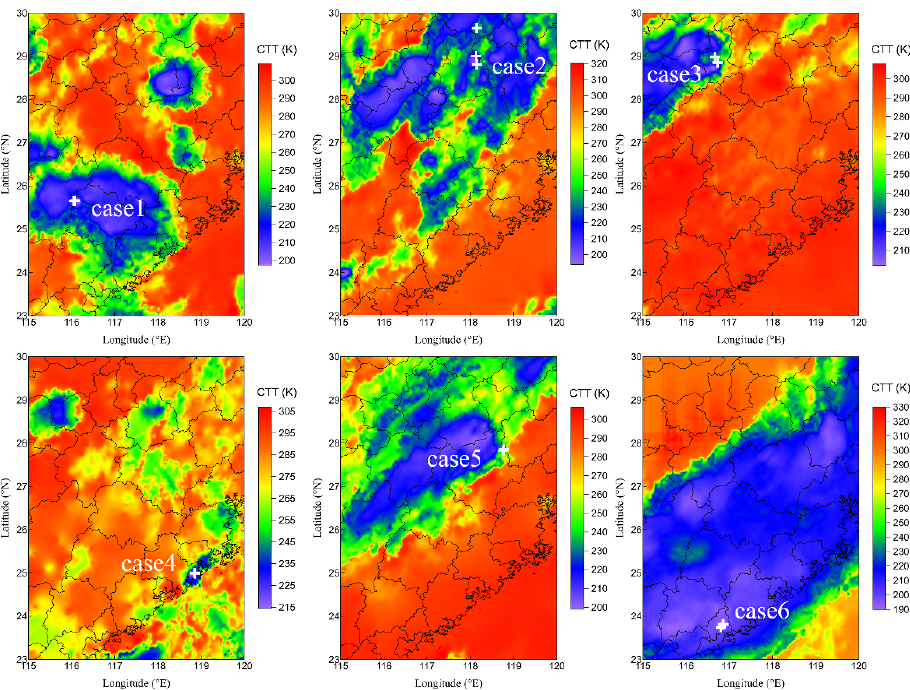
Figure 5. The reference locations of six cases superimposed on the cloud top temperature map. The white crosses mark the reference locations estimated by the ToA technique with three methods of arrival time differences.